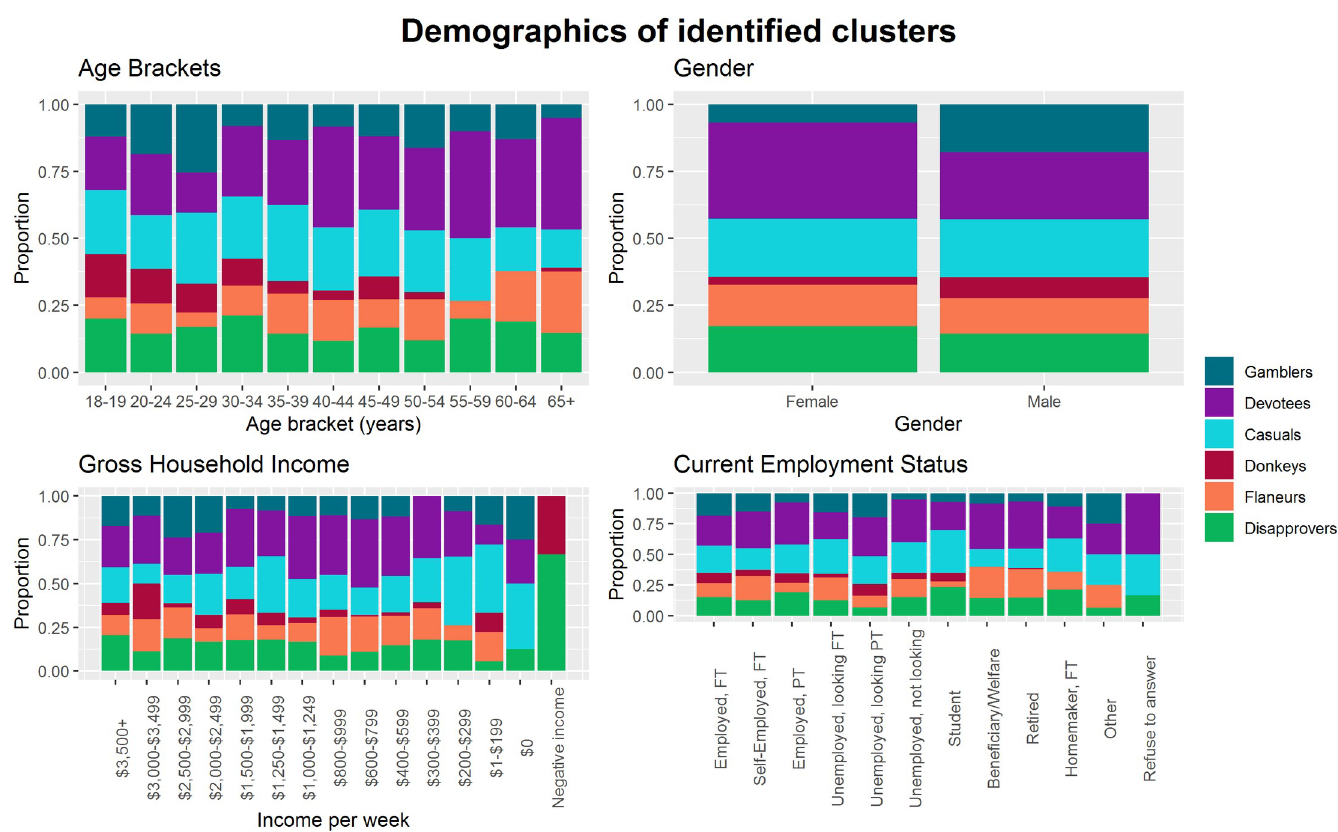
Fig 2. Demographics of respondents (n = 1028) assigned to six clusters by ordinal agreement with six statements regarding attitudes to the Melbourne Cup.